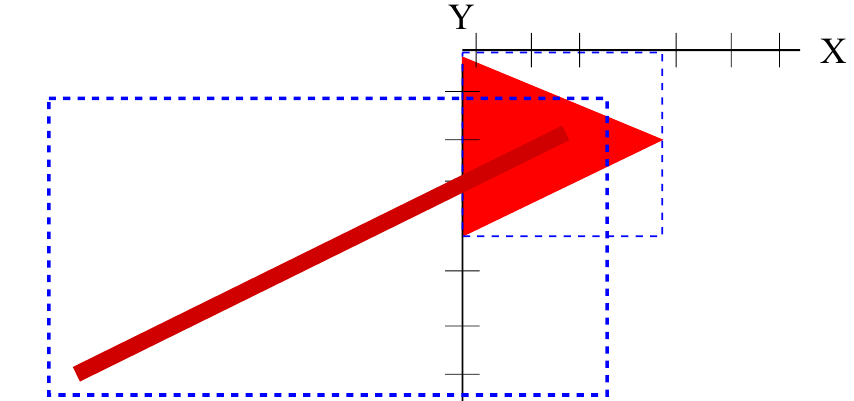
Figure 25: Curve with mapped arrow head and no rotational